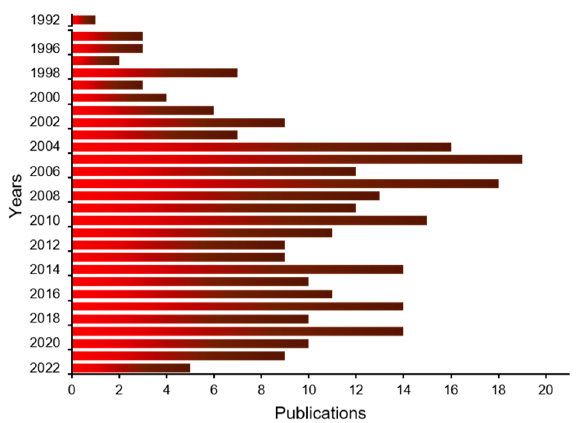
Figure 1. Chronology of TIAR research publications. Bar graph-like representation of TIAR years/publications searching for TIAR/TIAL1 terms in PubMed (https://pubmed.ncbi.nlm.nih.gov; accessed on 13 June 2022).